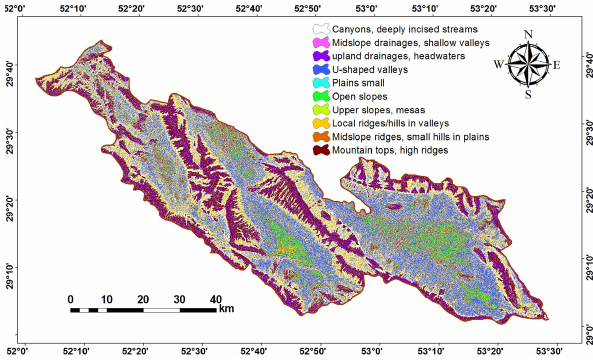
Figure 8. Landform classification using the TPI method.